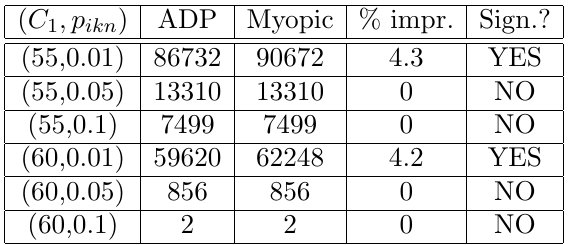
Table 4. Results for the relaxed tol- erance case with N =